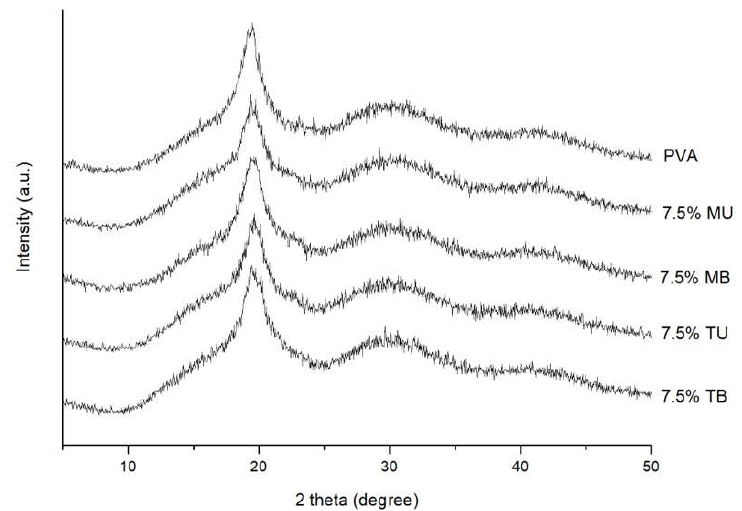
Figure 3. X-ray diffractograms of pure PVA and PVA-(L)CNF films.